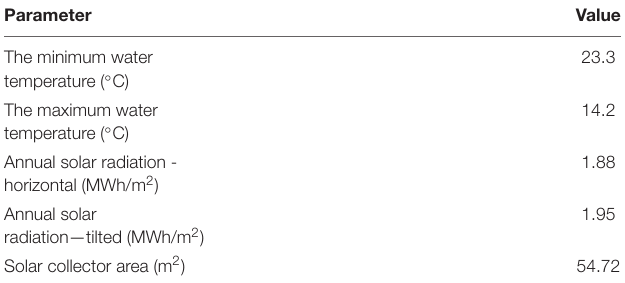
TABLE 5 | Values calculated from the technical